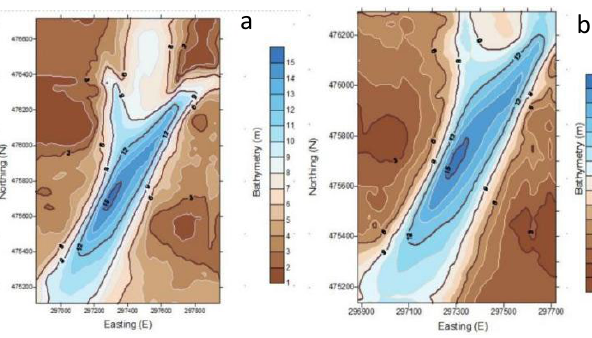
Figure 27. The bathymetric plan generated using Surfer in 2D. a) The bathymetric plan in 2017 and b) the bathymetric plan in